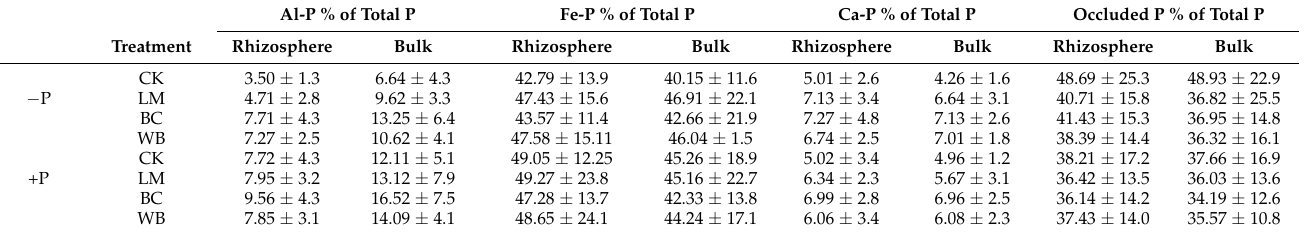
Table 3. Effect of biochar and P supply on phosphorus fractions relative share of total P in the rhizosphere and bulk